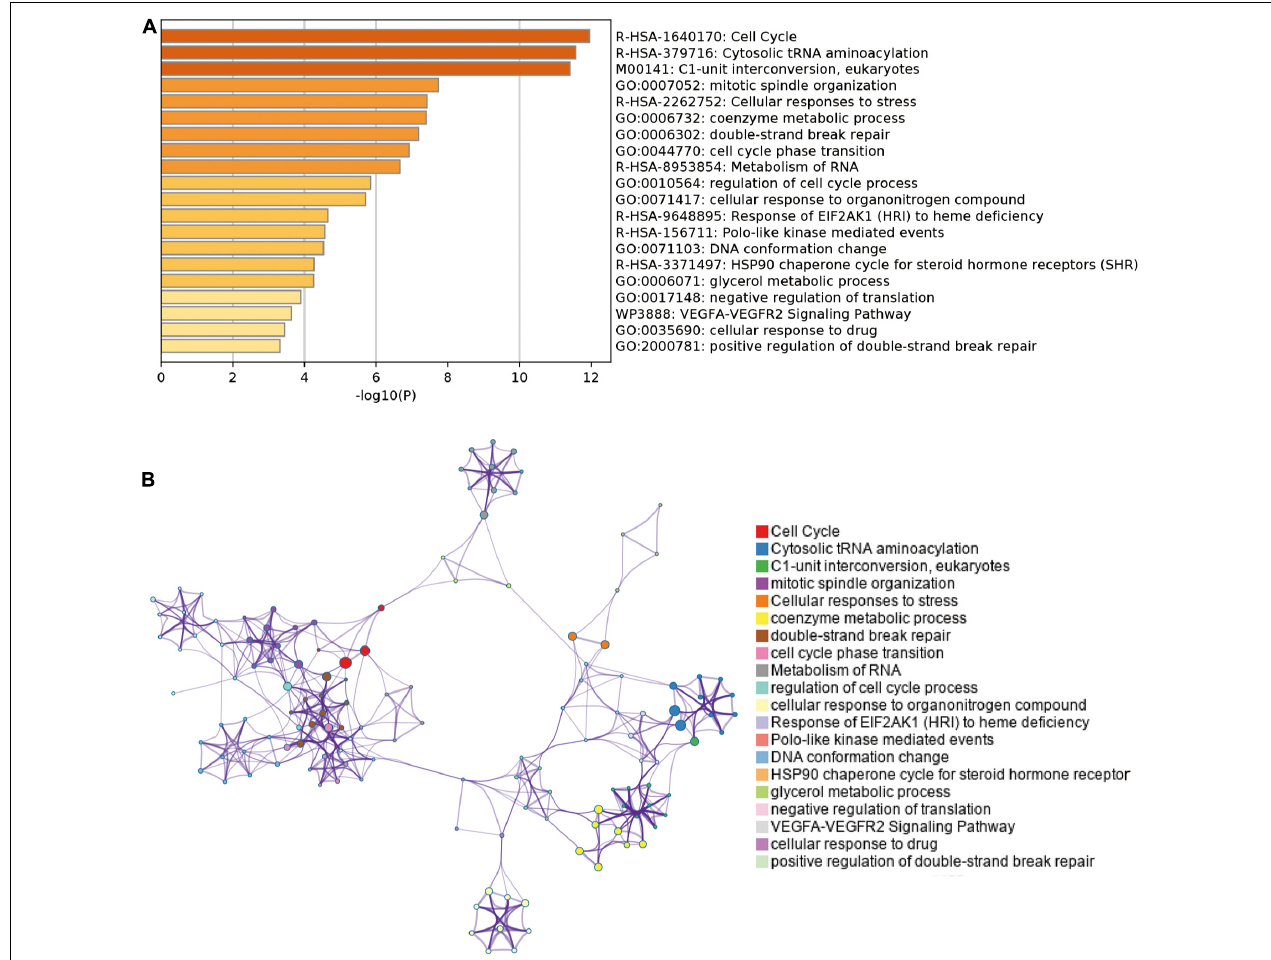
FIGURE 5 | Enrichment analysis of genes co-expressed with SHMT2 in Metascape. (A) Top 20 enriched functional terms of SHMT2-related genes are shown in the bar graph, terms are colored according to P -values. (B) Network of enriched functional terms, nodes shown in the same color share one term. P < 0.05 was recognized as statistically